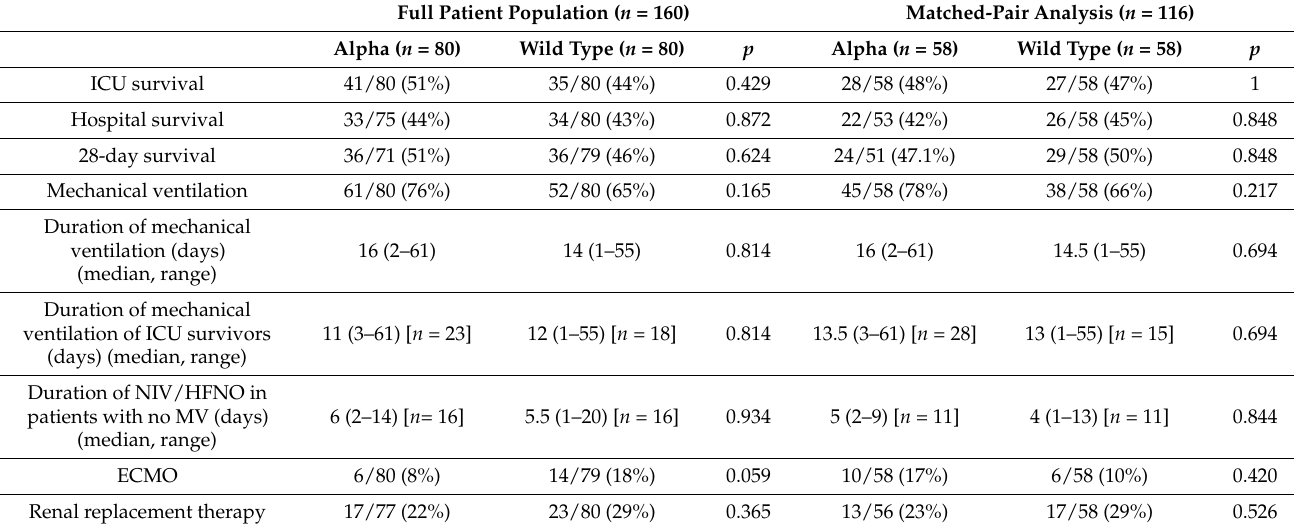
Table 2. Outcome and ICU-specific therapies both in the full patient population as well as in the matched-pair analysis (sex, age). No significant differences were identified between the SARS-CoV2 Alpha variant group and the SARS-CoV2 wild-type group. MV = mechanical ventilation; NIV = non-invasive ventilation; HFNO = high-flow nasal